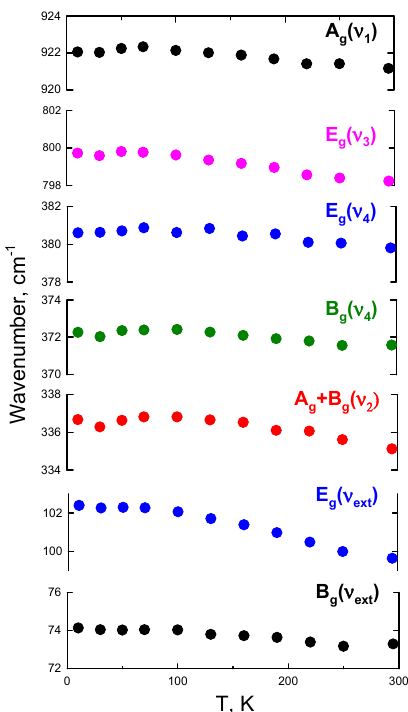
Figure 3. Temperature dependences of the frequencies of the Raman modes in SrWO 4 crystal.